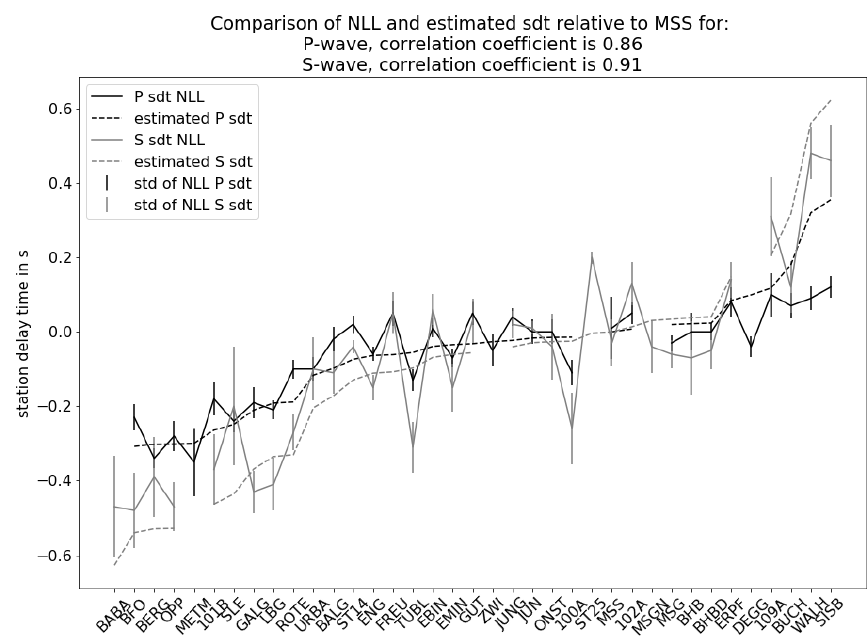
Figure 9. Comparison of NLL station delay times (sdt) and estimated station delay times due to depth variations of the crystalline basement: P waves (black) and S waves (gray). Stations along the x axis are sorted from shallow to deep crystalline basement model